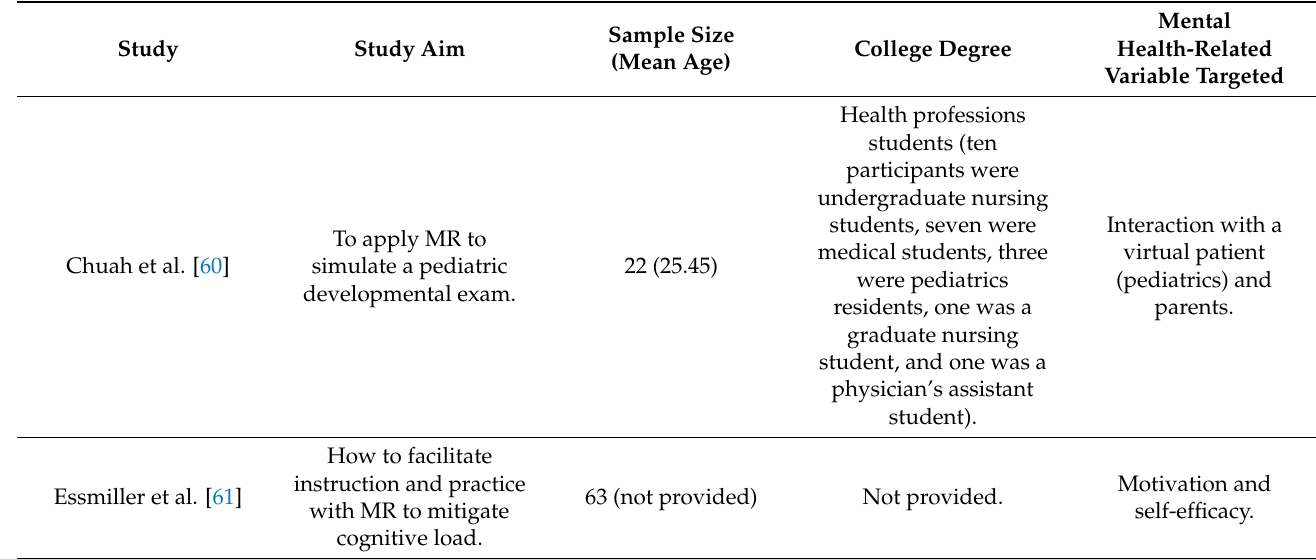
Table 2. General characteristics of included studies (II) (n =